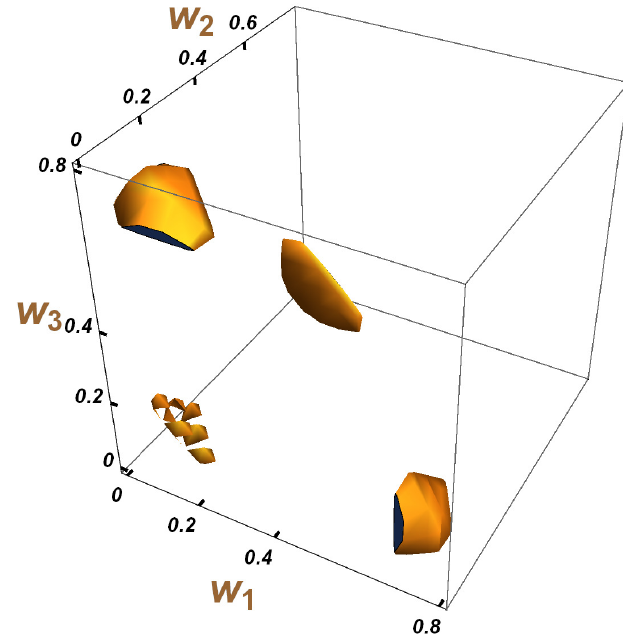
Figure 11: Corresponding to any point from the shaded re- gions of the parameter space ( w 1 , w 2 , w 3 ) , absolutely local Bell diagonal state (25) is useful in our QKD